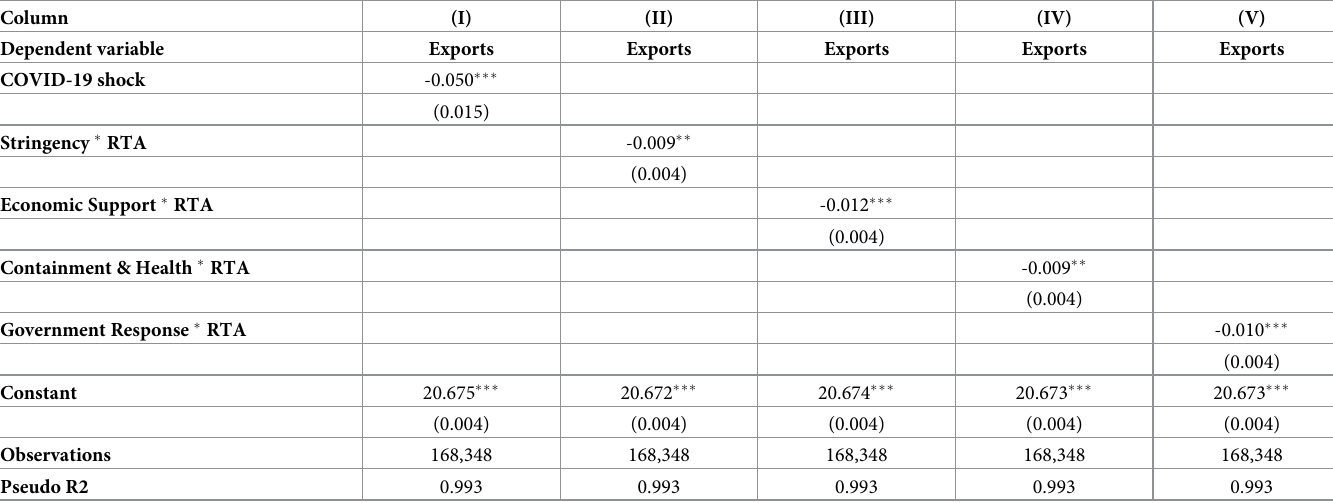
Table 3. Results by COVID-19 government response indicator estimated by PPML, January 2019-October